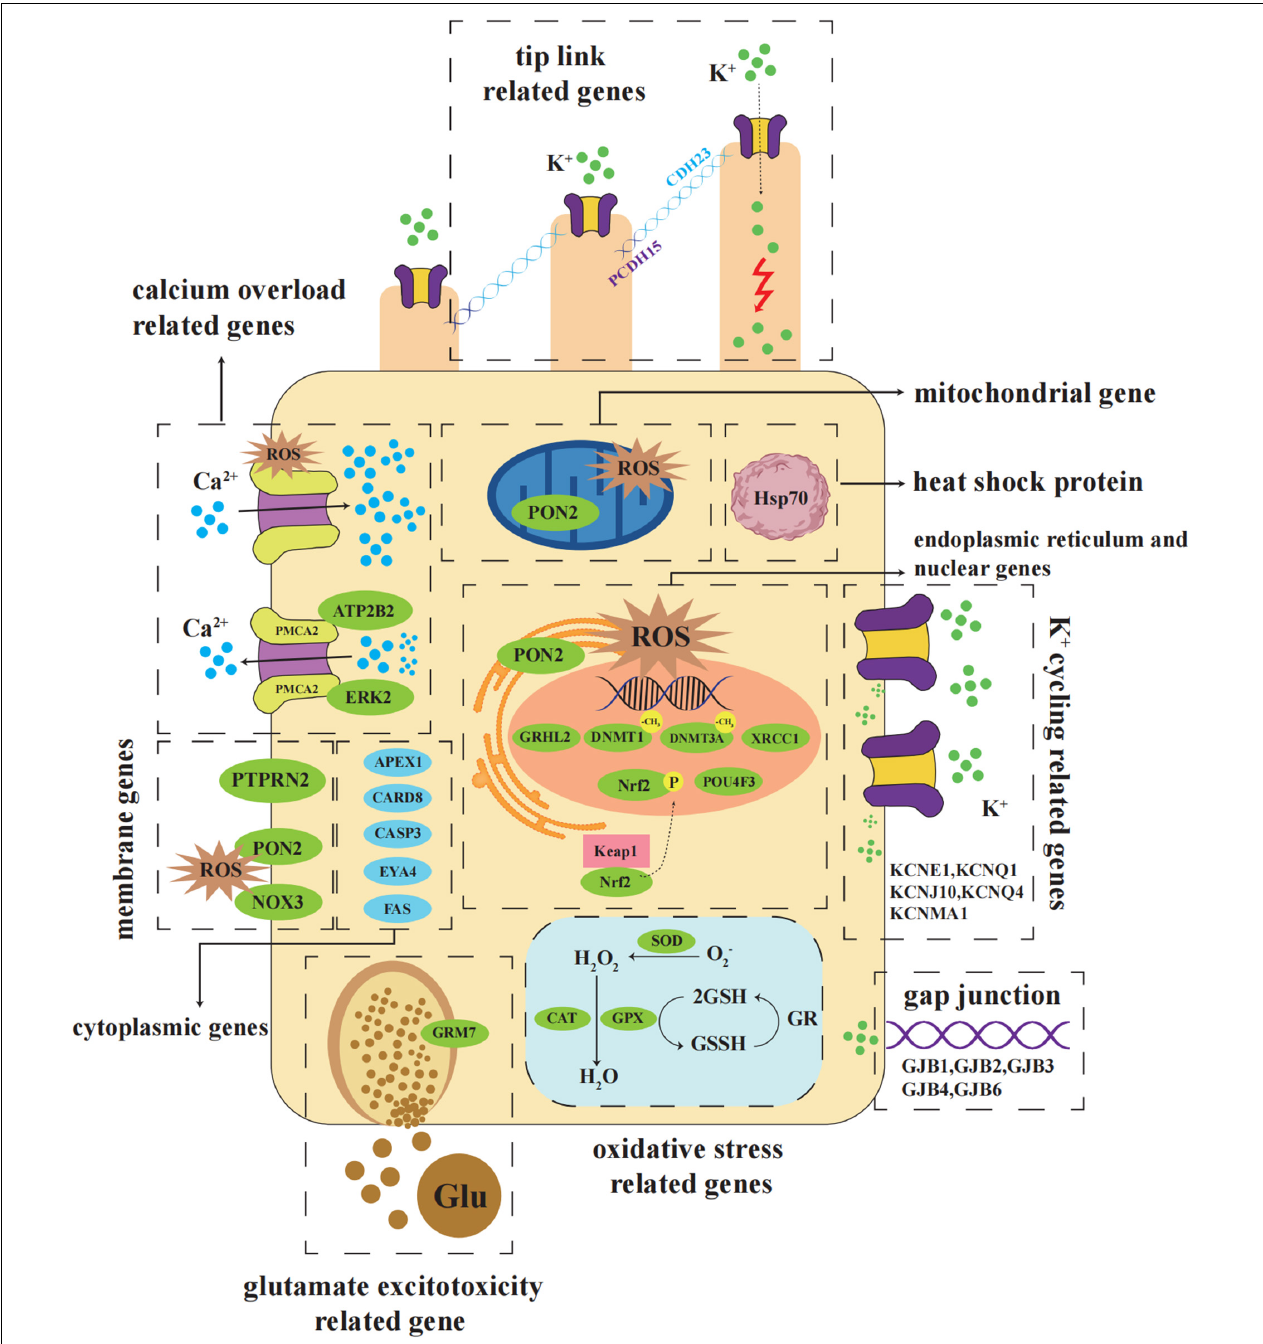
FIGURE 1 | Schematic diagram of major NIHL susceptible genes distributed in the hair cells. NIHL susceptible genes are involved in the progression of oxidative stress, potassium ion cycling, calcium overload, glutamate excitotoxicity, DNA damage repair, apoptosis, and other biochemical processes. They are distributed in various locations in cells, including membrane, cytoplasm, nucleus, mitochondria, and endoplasmic reticulum. Abbreviations: Glu, Glutamate; GR, Glutathione reductase; GSH, Glutathione; GSSH, Glutathione oxidized; Keap1, Kelch-like ECH associated protein 1; PMCA2, Plasma membrane calcium-transporting ATPase 2; ROS, Reactive oxygen